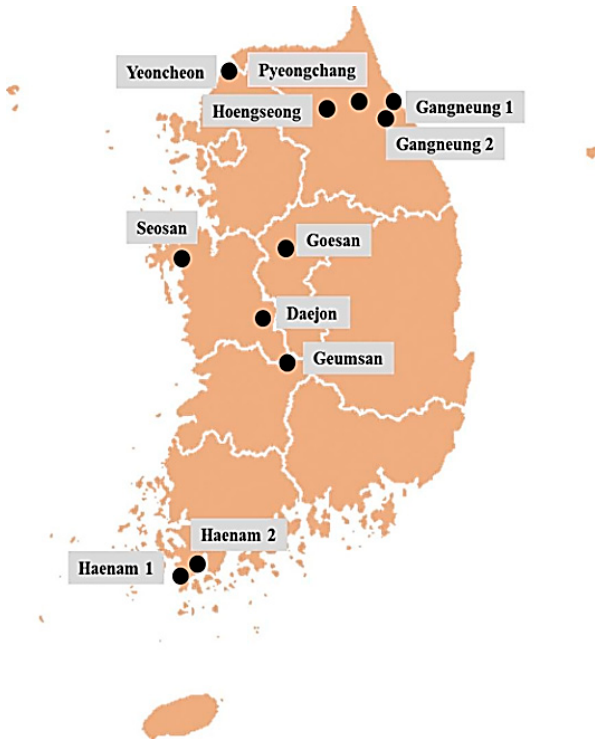
Figure 2. Sampling sites of 11 P. brassicae field populations (geographical isolates) from nine different regions of South Korea.